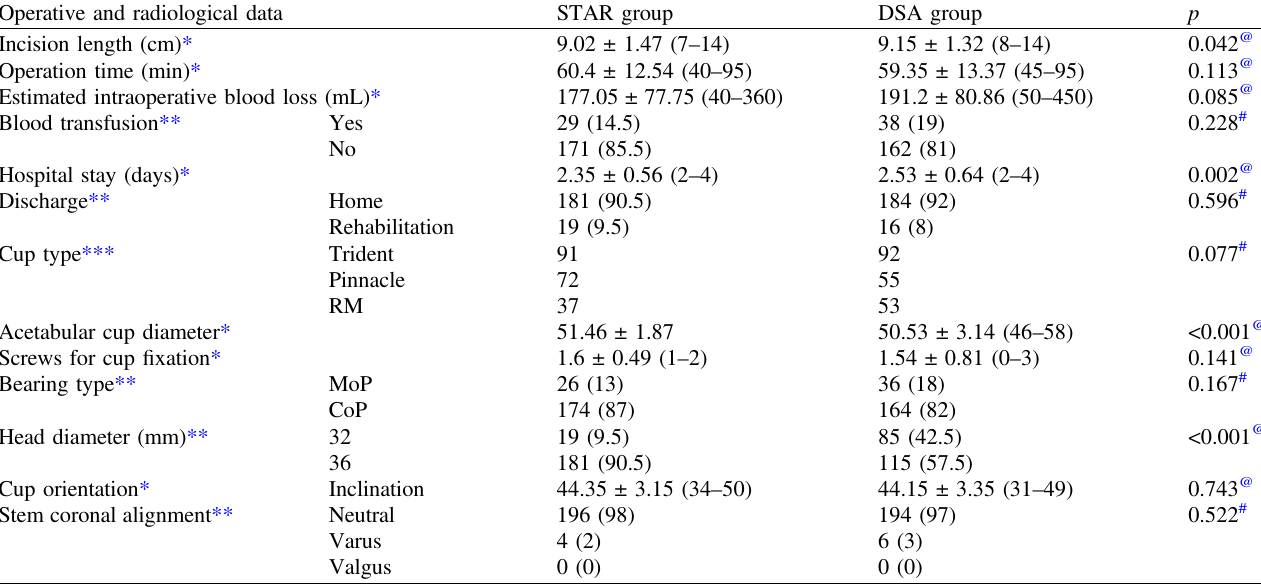
Table 2. Intraoperative and postoperative clinical and radiological data of both groups. Operative and radiological